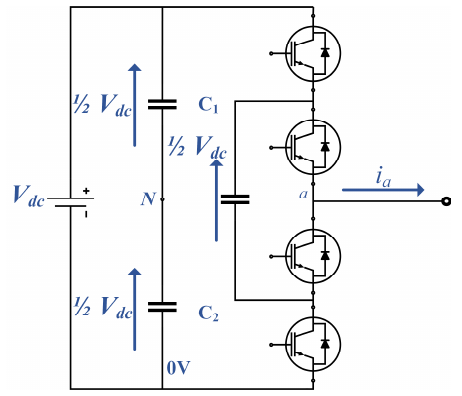
Figure 12. Three-level flying capacitor converter phase